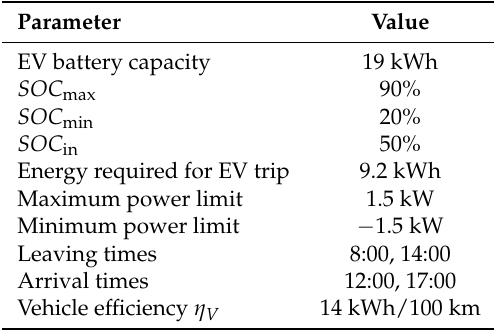
Table 1. EV parameters.